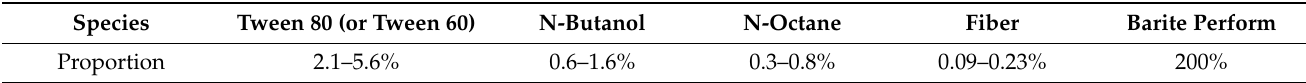
Table 2. Nano-cleaning fluid formula.